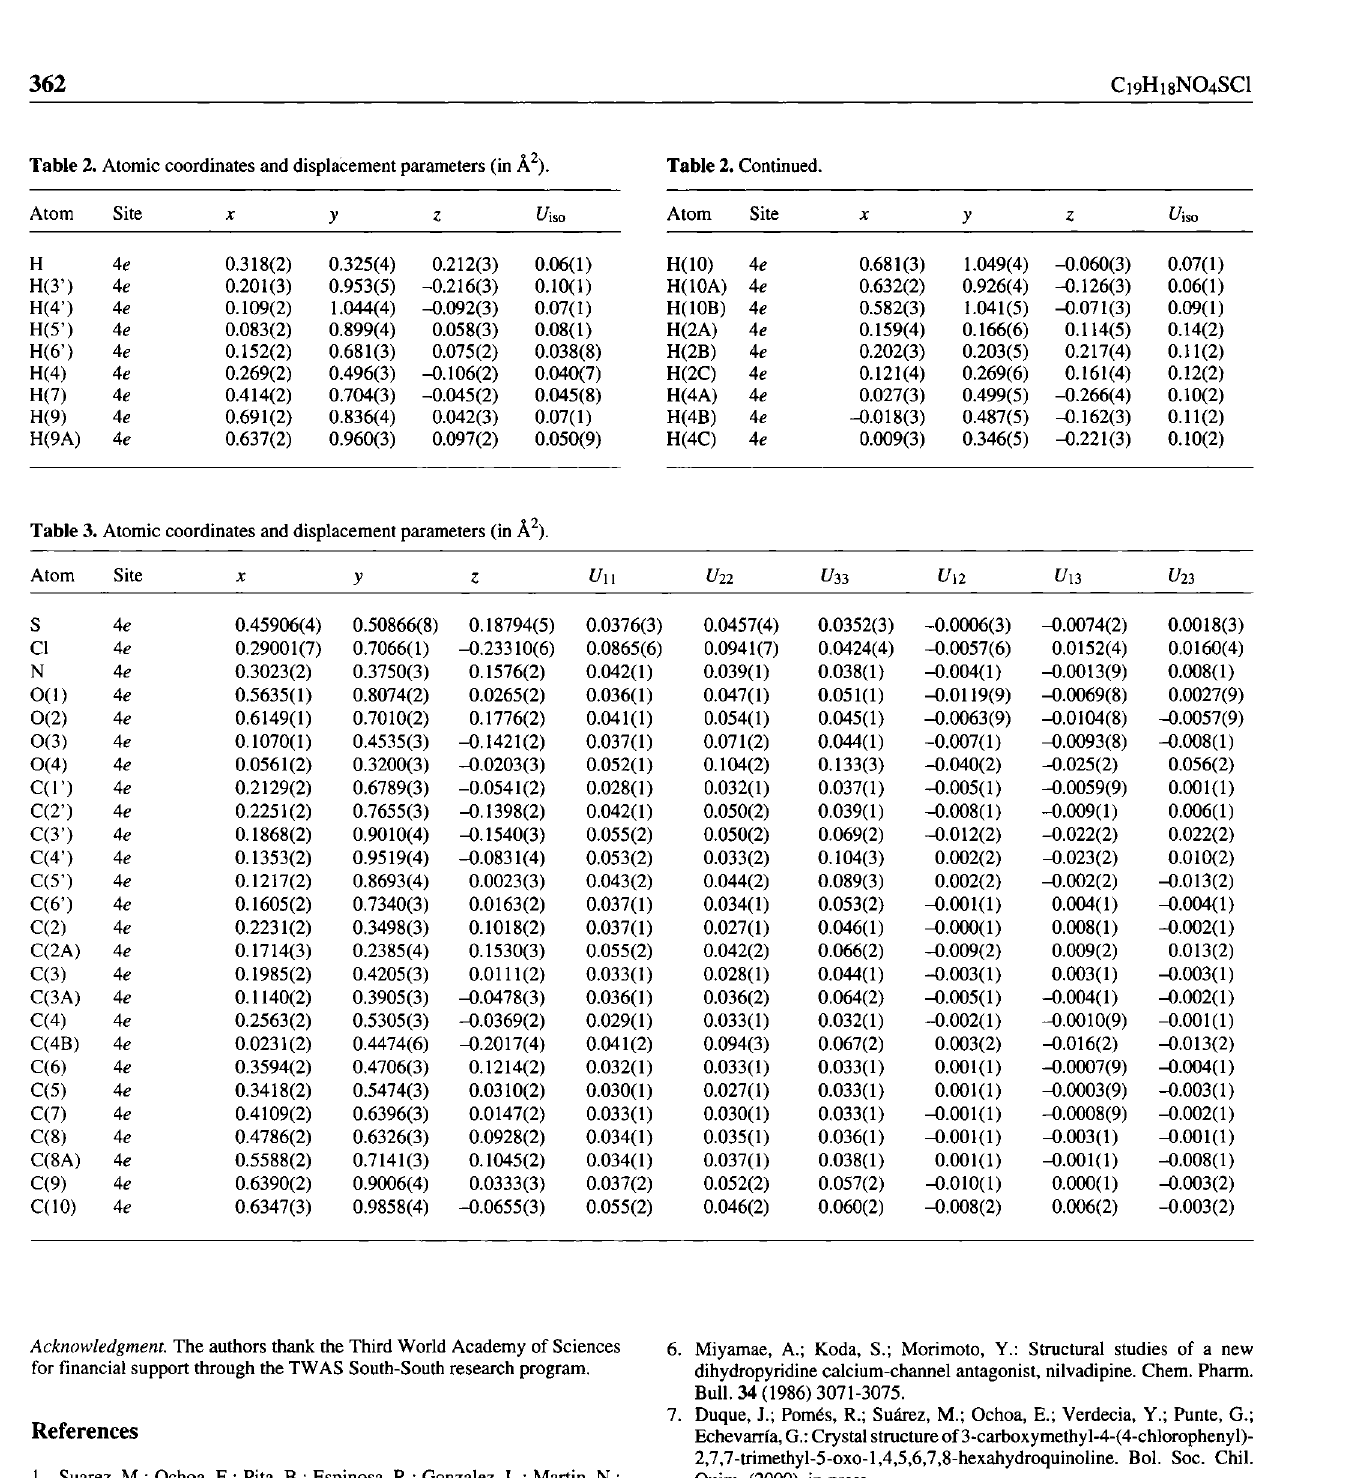
Table 2. Atomic coordinates and displacement parameters (in Ä 2 ). Table 2. Continued.